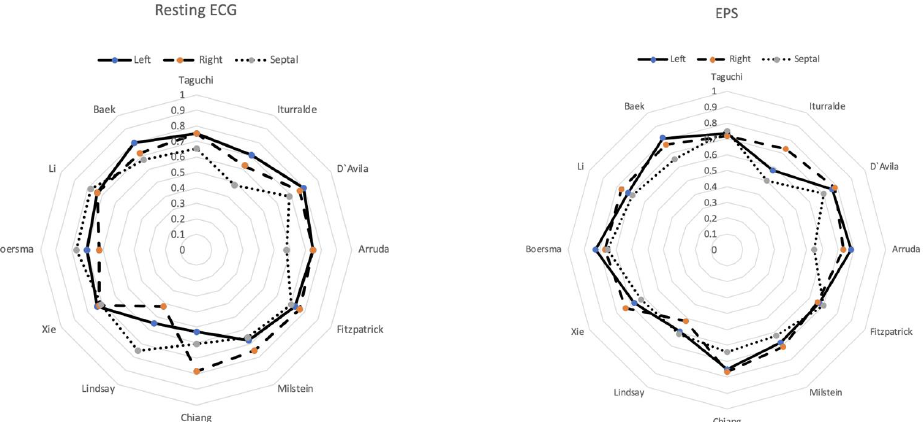
Figure 1. Prediction accuracy for laterality from 12 lead resting ECG tracings and ECG tracings with full ventricular preexcitation during